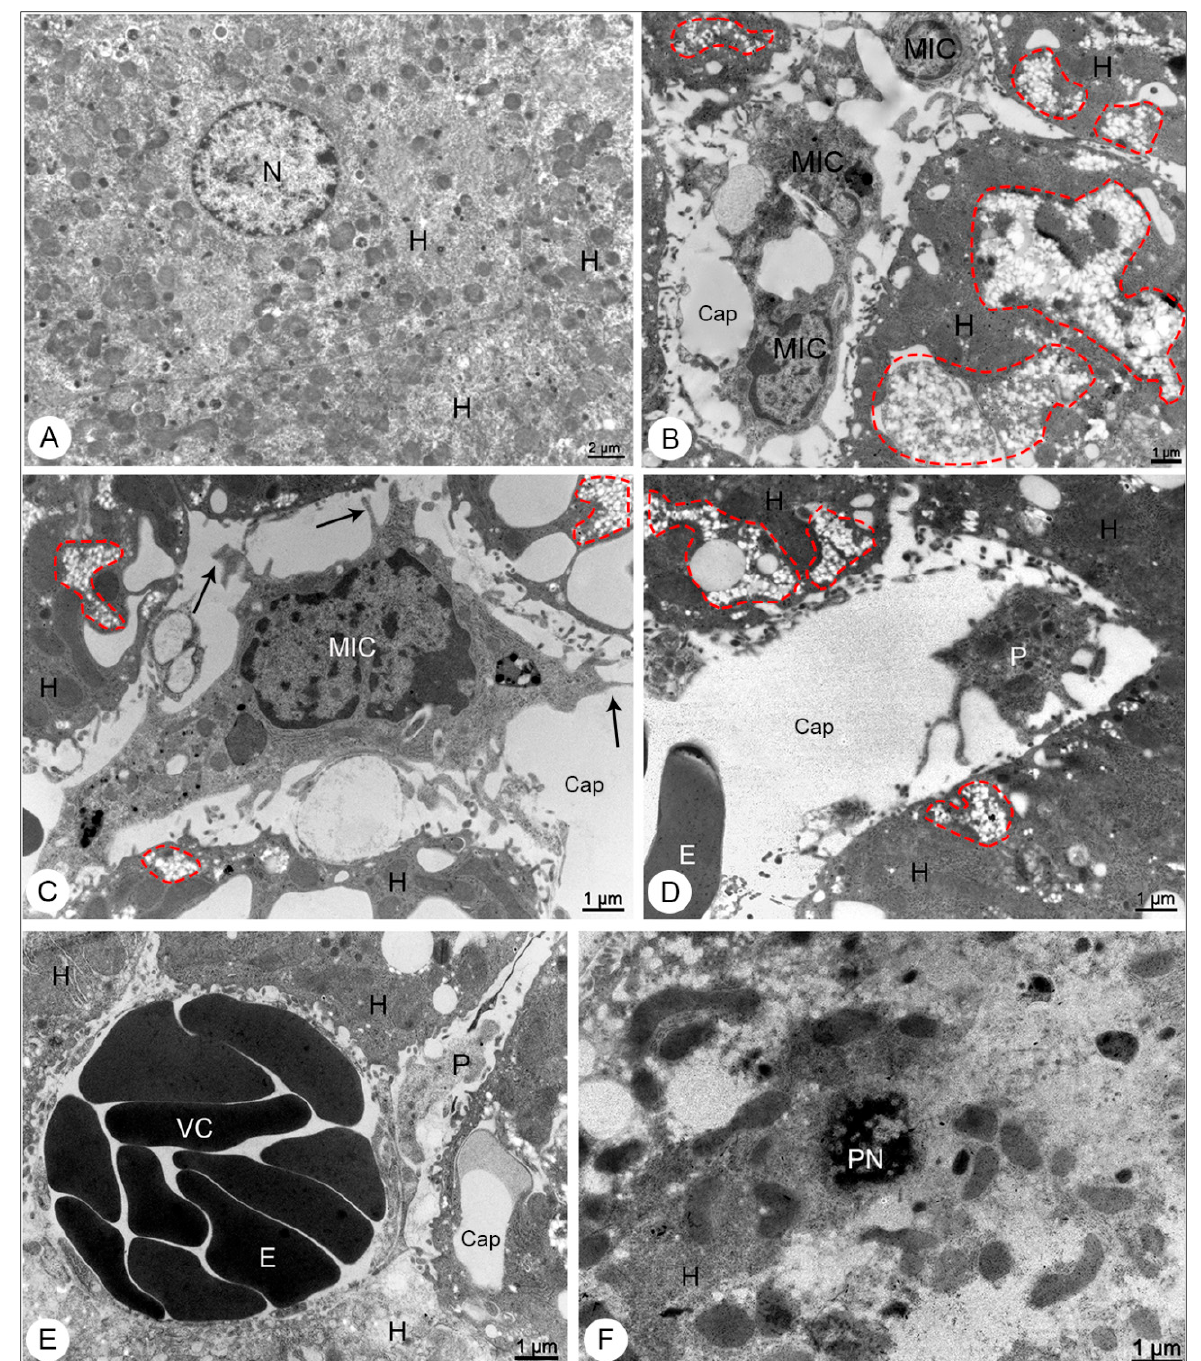
Figure 3. Liver samples of BALB/c mice observed in transmission electron microscope. ( A ) Negative control sample. Hepatocyte (H); nucleus (N). ( B – F ) DENV-4-infected samples. Microvesicular steatosis (dashed outline); mononuclear inflammatory cells (MIC) presenting filopodia (arrows); capillary (Cap); hepatocytes (H); activated platelet (P); erythrocyte; vascular congestion (VC); pyknoctic nucleus (PN). Magnification: ( A ) = 5000×; ( B ) = 8000×, ( C ) = 12,000×; ( D ) = 10,000×; ( E ) = 12,000×; ( F ) = 12,000×.